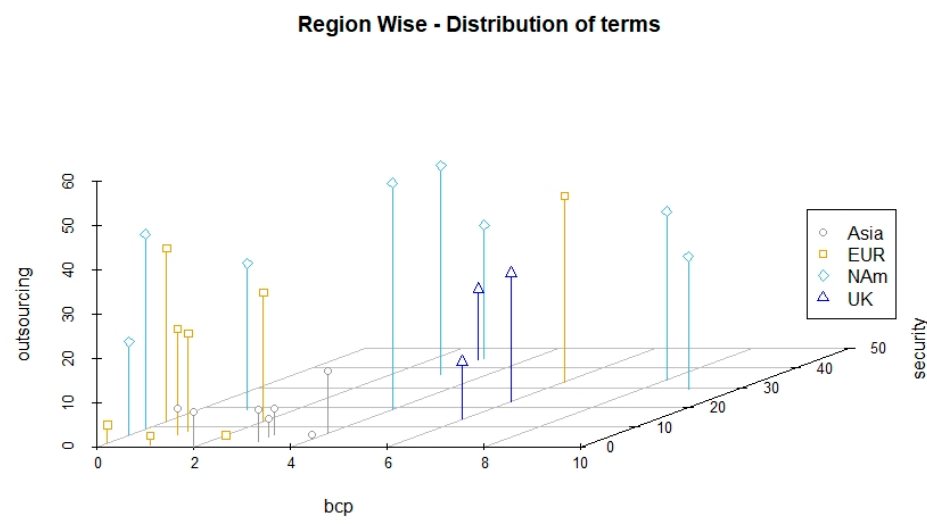
Figure 3. Distribution of resiliency terms by region of the GSIB.